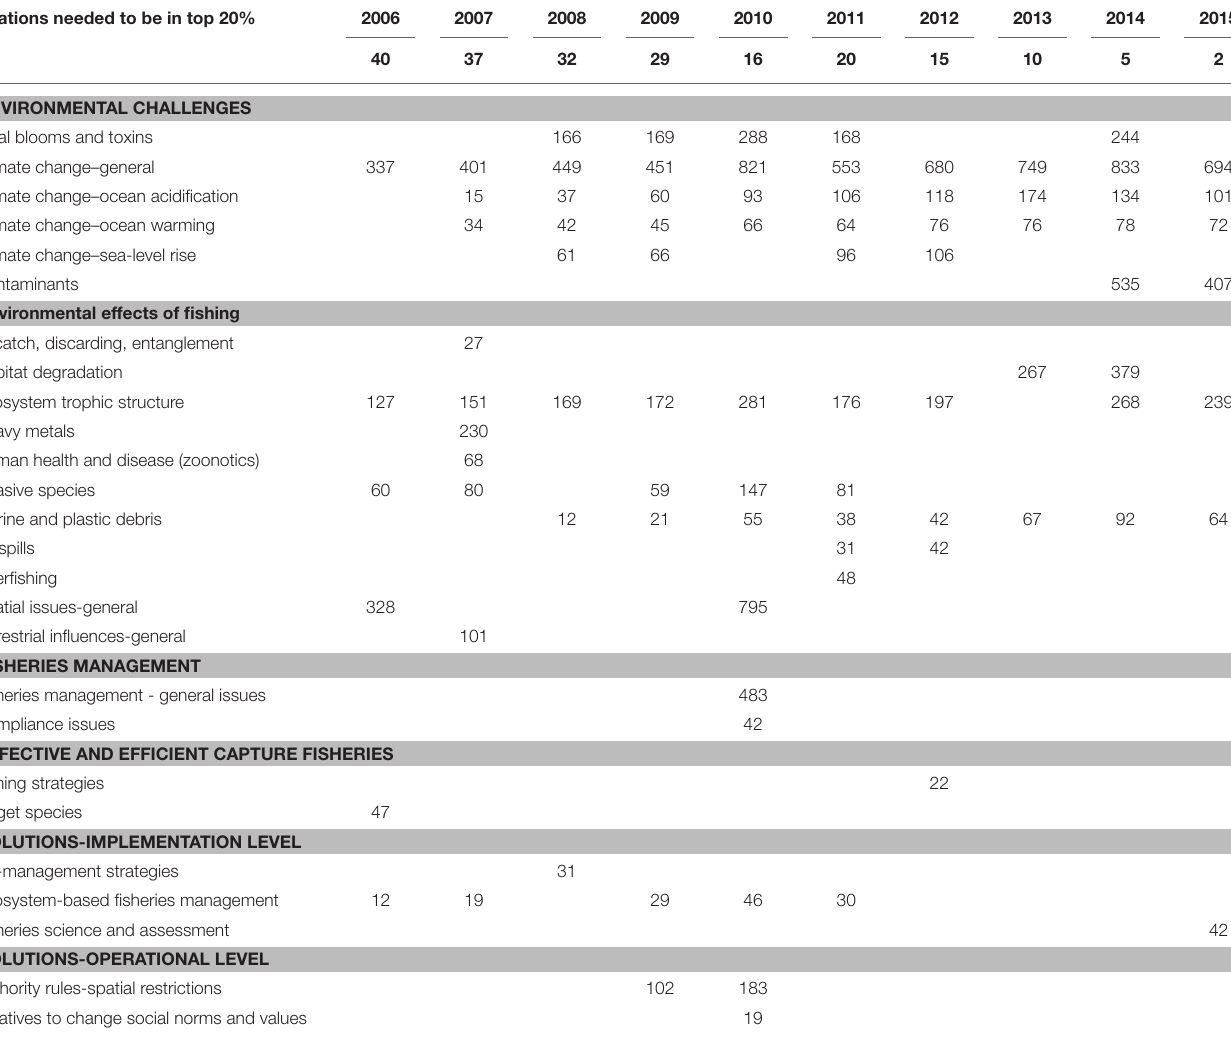
TABLE 3 | Number of highly-cited articles (top 20% of citations of articles for the year) by challenge and solution category; based on total ISI citations at the time of Web of Science data download (July 2016). Citations needed to be in top